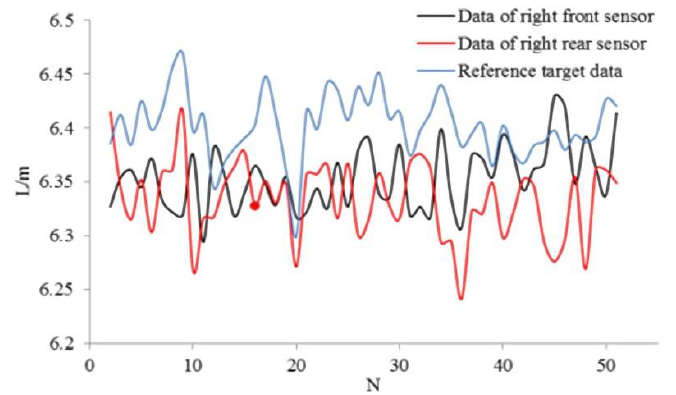
Figure 15. Recognition data of two sensors and reference target data.